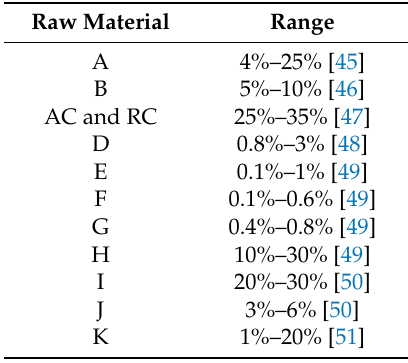
Table 1. Percentage levels of raw materials.